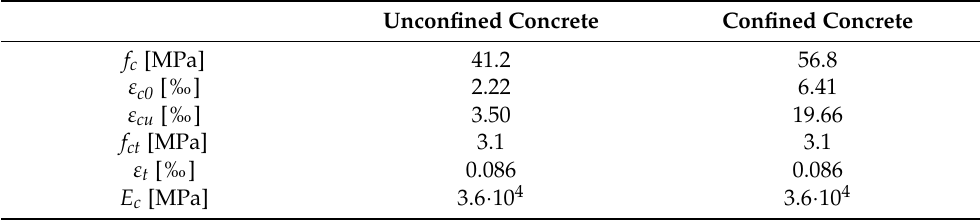
Table 2. Compressive strength ( f c ), corresponding compressive strain at f c ( ε c0 ), ultimate strain ( ε cu ), axial tensile strength ( f ct ), tensile strain at f ct ( ε t ) and elastic modulus ( E c ) of confined and unconfined